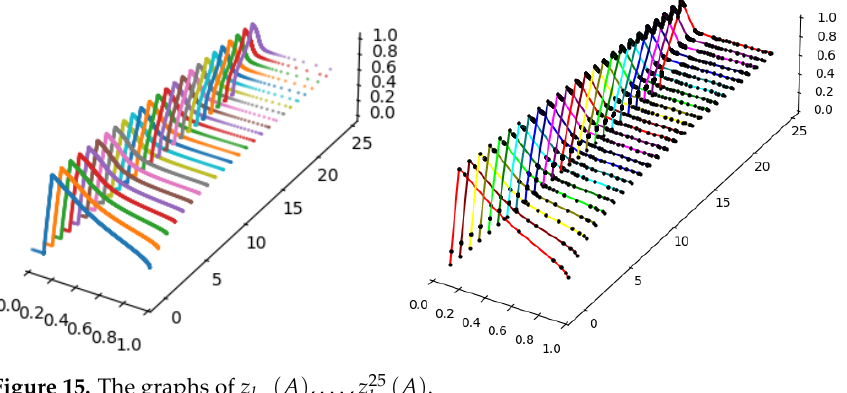
Figure 15. The graphs of z l